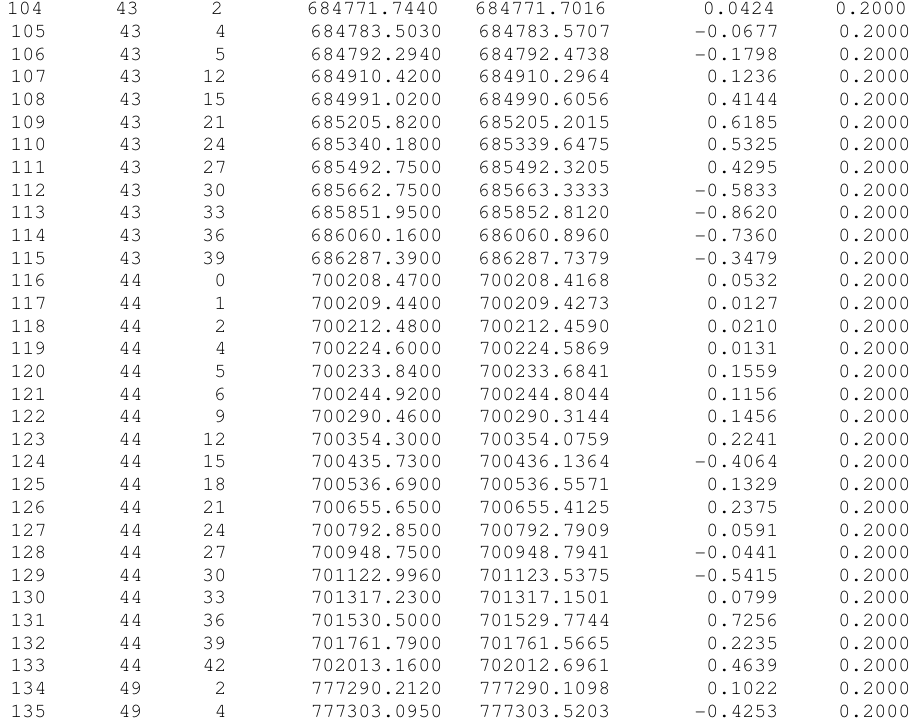
Table 5 . Results of refinement of observed frequencies for PF Parameter G.S. (Ref. 6) G.S. this